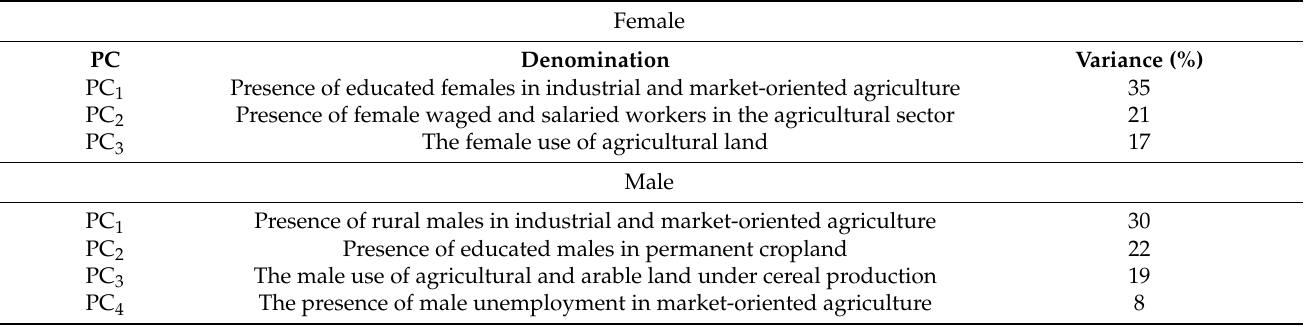
Table 7. Denomination of the new latent factors with the percentage of variance (female vs. male). Female